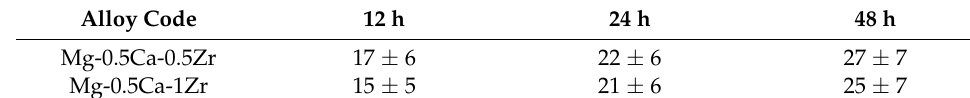
Table 1. Mean grain sizes of the aged Mg alloys with the aging time ( µ m).